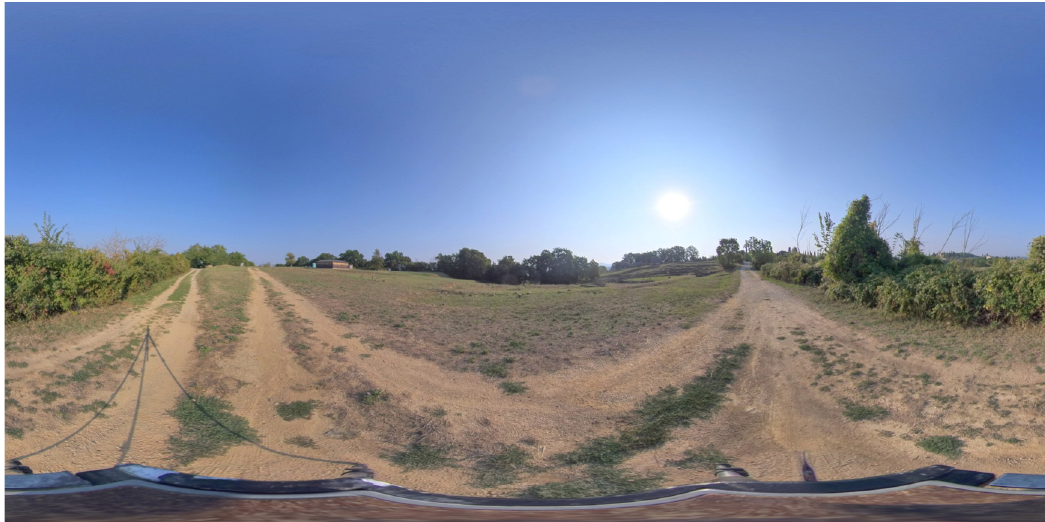
Figure 7: 360° photograph realized with Insta360 One X.